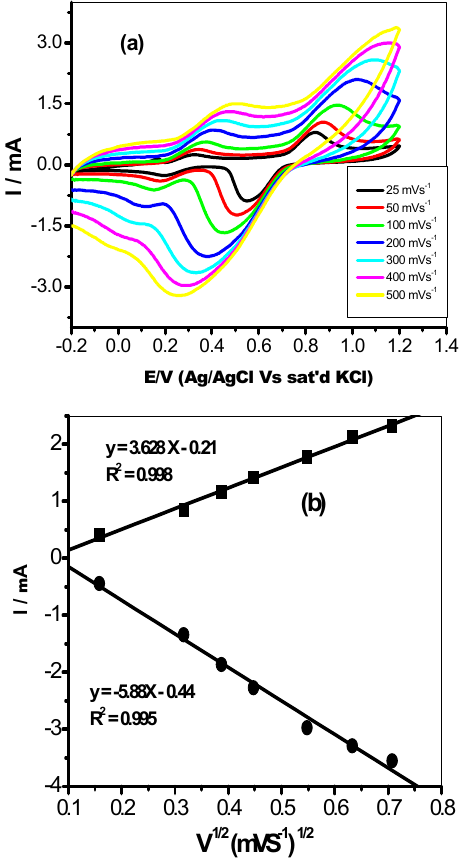
Figure 6. Cyclic voltammograms obtained for ( a ) GCE/CA-AgNPs/MWCNT in FECN solution prepared in 0.1 M PBS (scan rate: 25–500 mVs − 1 ; inner to outer); ( b ) Linear plots of I pa vs. V 1/2 and I pc vs. V 1/2 for GCE/CA-AgNPs/MWCNT in 5 mM Fe(CN) 6 ] 4 − /[Fe(CN) 6 ] 3 − solution prepared in 0.1 M PBS.